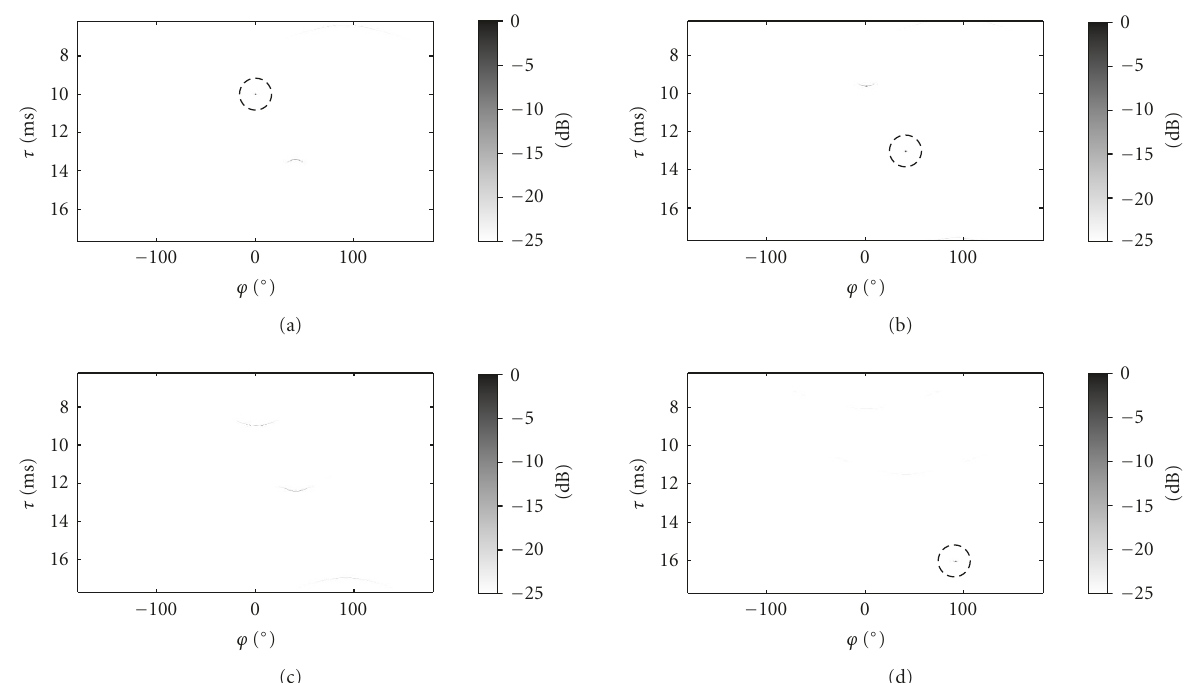
Figure 9: Result of cylindrical harmonic decomposition of the simulated data of Figure 3. Model space frames are shown for elevation angles: (a) θ = 0 ◦ , (b) 30 ◦ , (c) 50 ◦ , and (d) 70 ◦ . The representations of the three waves in the data set are marked with circles in the corresponding elevation angle frames.